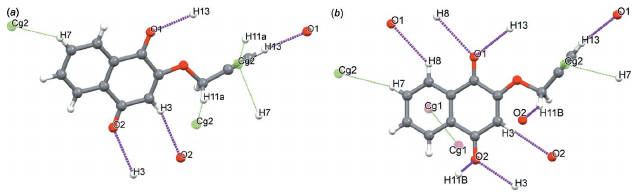
Figure 3 Selected intermolecular interactions in the crystals of ( a ) the monoclinic form and ( b ) the triclinic form. Purple dashed lines represent the C— H (cid:2)(cid:2)(cid:2) O hydrogen bonds and green dashed lines the C—H (cid:2)(cid:2)(cid:2) (cid:2) and (cid:2) – (cid:2) interactions. Cg 1 is the centroid of the C5–C10 ring, while Cg 2 is the midpoint of the C12 C13 bond.